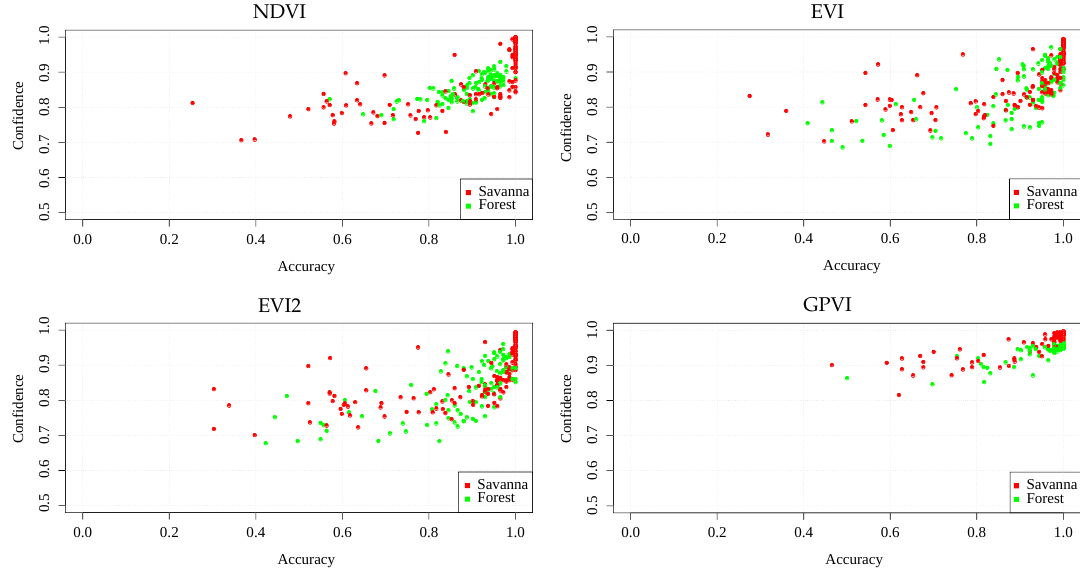
Figure 6. Confidence vs. accuracy in each area (Landsat).